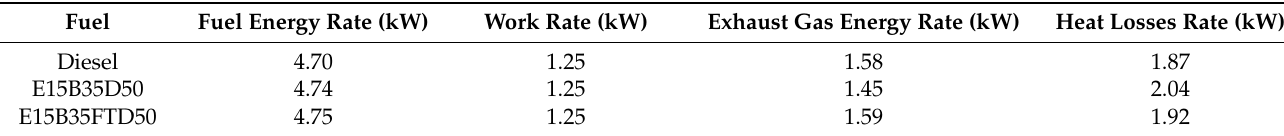
Table 4. Energy distribution in the engine control